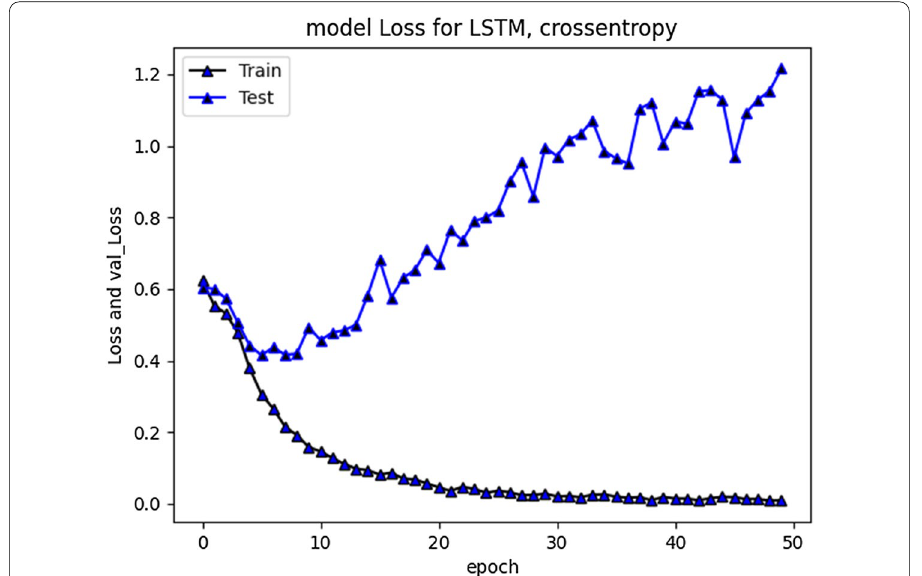
Fig. 8 RNN-LSTM Model loss plot- Binary Cross entropy for 50 epochs